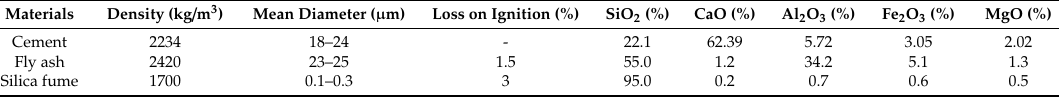
Table 1. The chemical compositions and physical properties of cement, silica fume and fly ash.